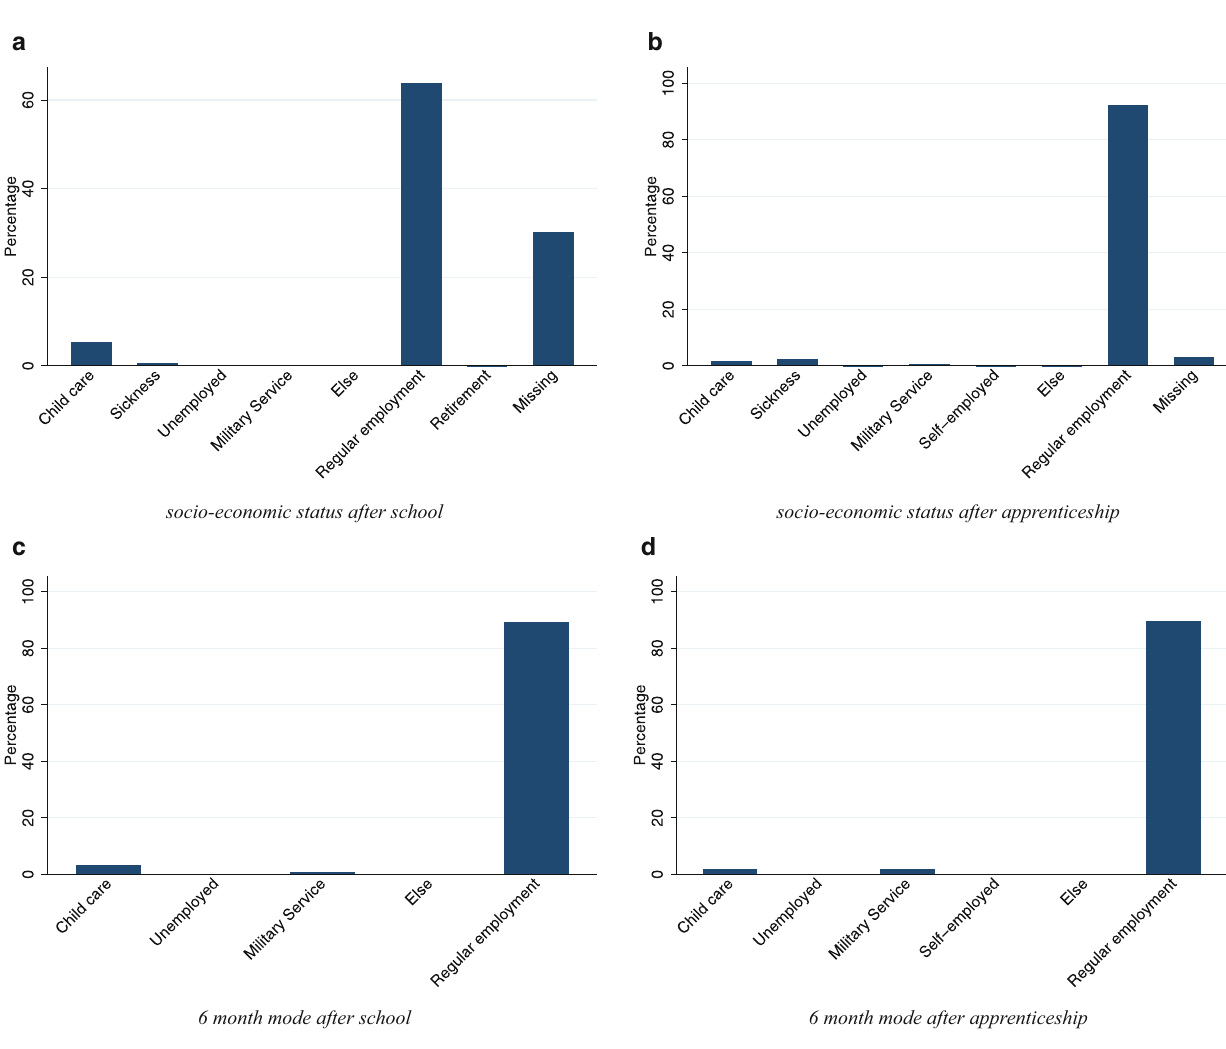
Fig. 3 Socio-economic status after the eduction period. ( Source: BASiD 2007. Notes: The figure shows the socio-economic status after comple- tion of the eduction period. Sub-figures a and b focus on the first month after the eduction period. Sub-figures c and d plot the 6 month mode of the socio-economic